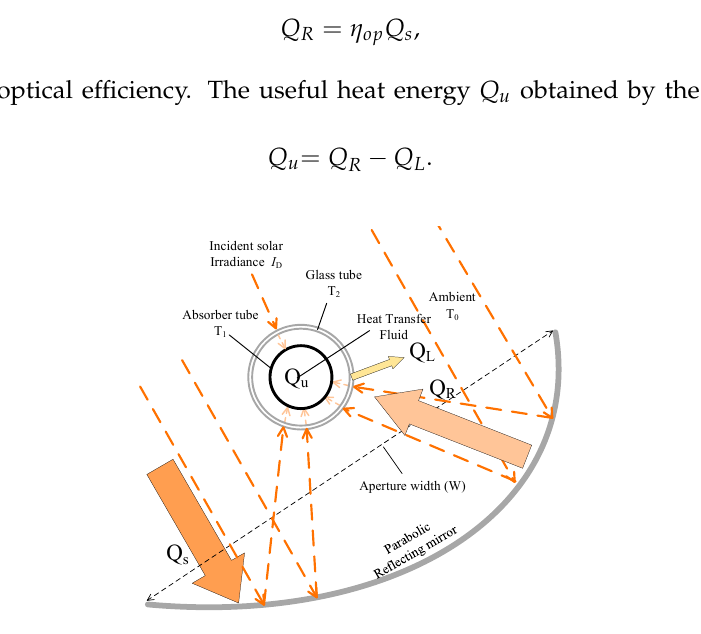
Figure 2. Parabolic trough collector thermal model.